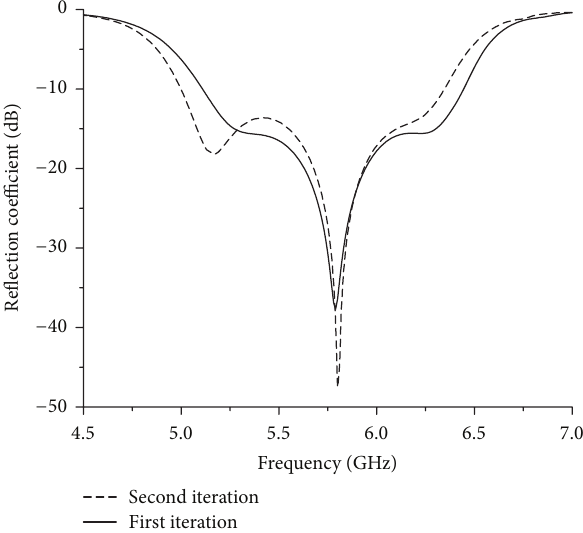
Figure 8: The simulated directivity as a function of frequency for the different fractal proportion.